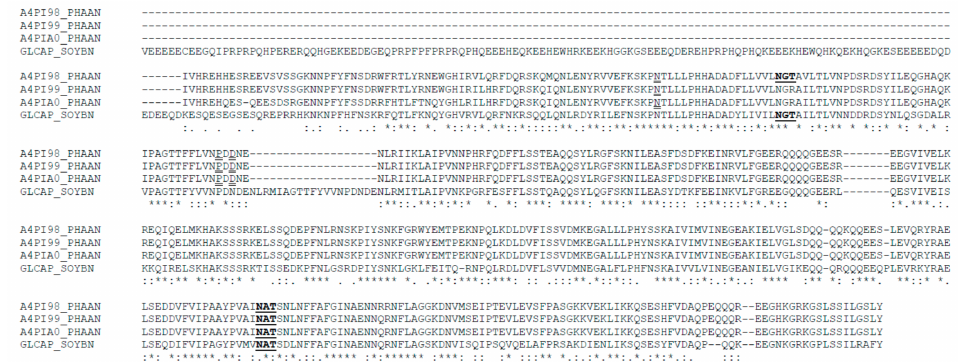
Figure 7. Adzuki bean β -vignin sequence alignment. The amino acid sequence of the β -vignin of adzuki ( Vigna angularis Willd.), available at UniProt/TrEMBL, was aligned by using Clustal W 1.83 (PHAAN). The sequence of the soybean (SOYBN) homologous protein is also shown. Each complete line shows 100 amino acid residues. Asterisks: identity; semicolon: conserved substitution; full stop: semi-conserved substitution. N-glycosylation consensus sequences (NXS, T) are in bold and underlined. High prediction signal peptide (Signal P 4.0 Server) of adzuki 7S globulin, confirmed by N-terminal sequencing (see text), is